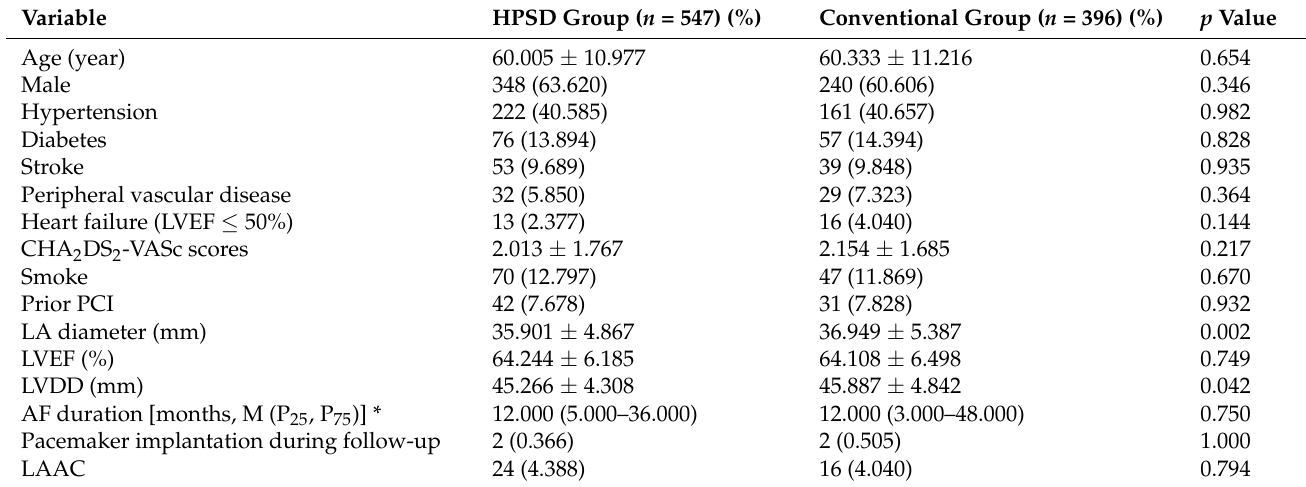
Table 1. Baseline characteristics of the study